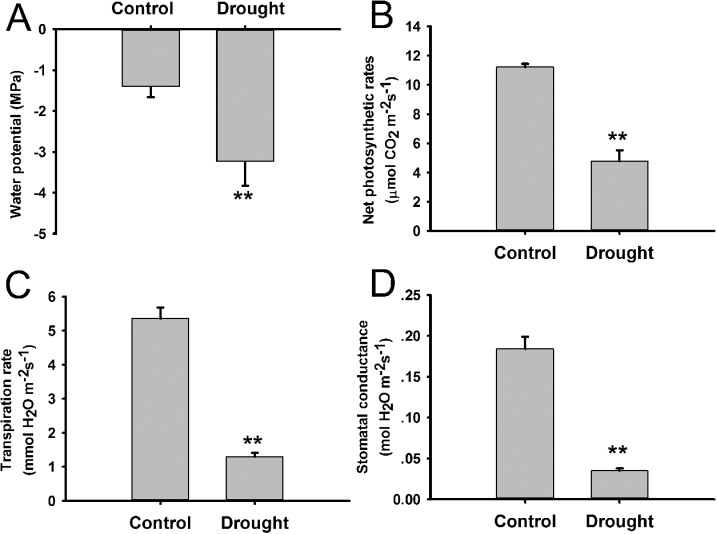

P. trichocarpa under control and drought conditions. Leaf WP (A), leaf net photosynthetic rates (B), transpiration rate (C), and leaf stomatal conductance (D) of P. trichocarpa under soil water deficiency. Results of the t test between control and drought treatments are shown. Values with asterisks (**) were significantly different at the P <0.001 level.